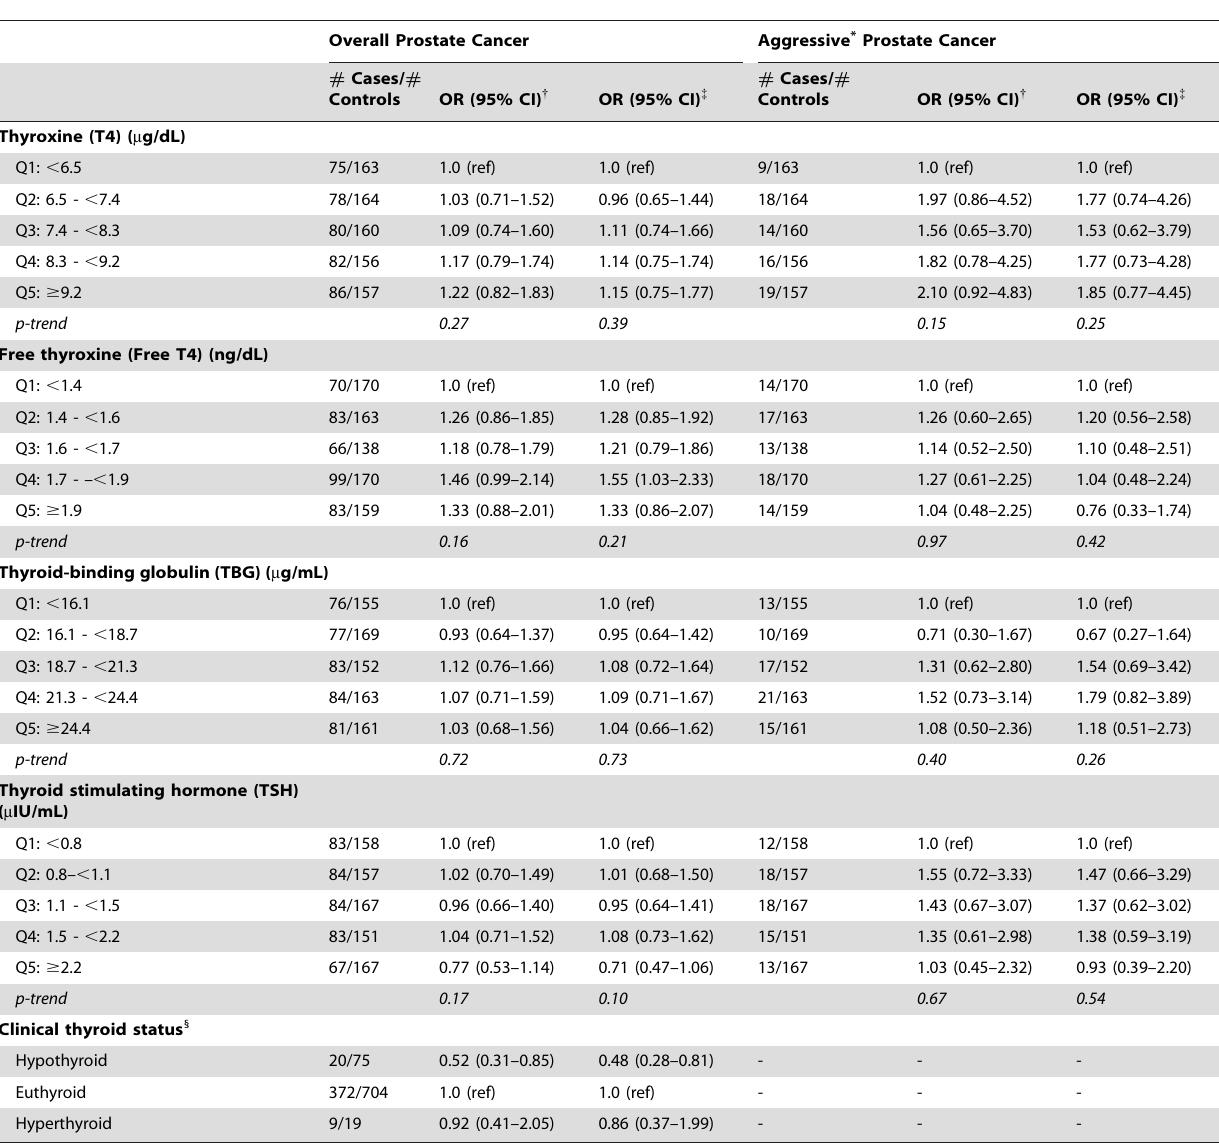
Table 4. Association between thyroid hormones and risk of overall and aggressive prostate